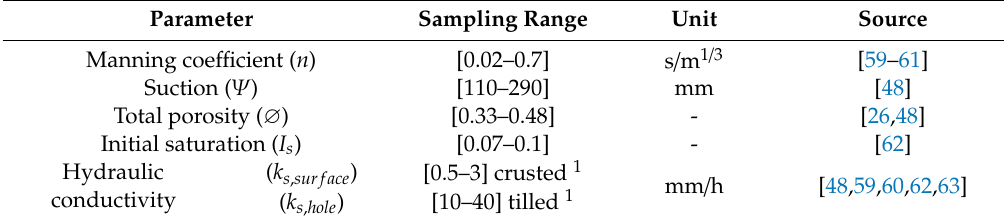
Table 2. Parameter ranges used in the Monte Carlo simulations.